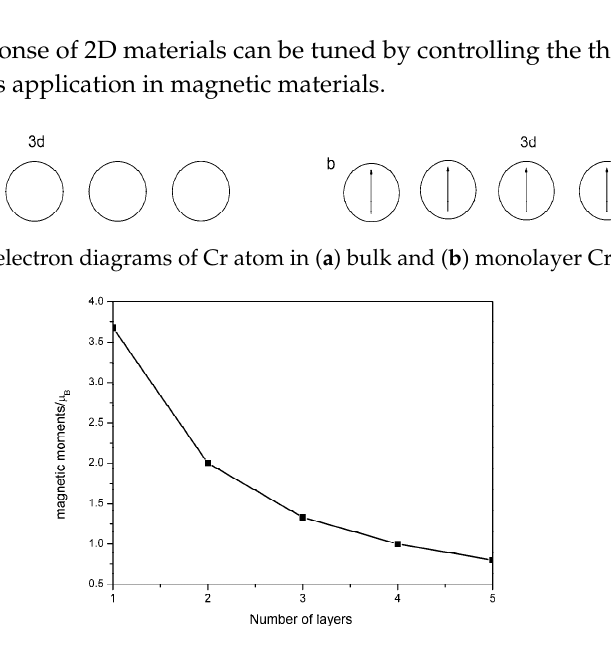
Figure 7. The magnetic moment of unit cell of multilayer CrSi 2 nanosheets varies with different layers.